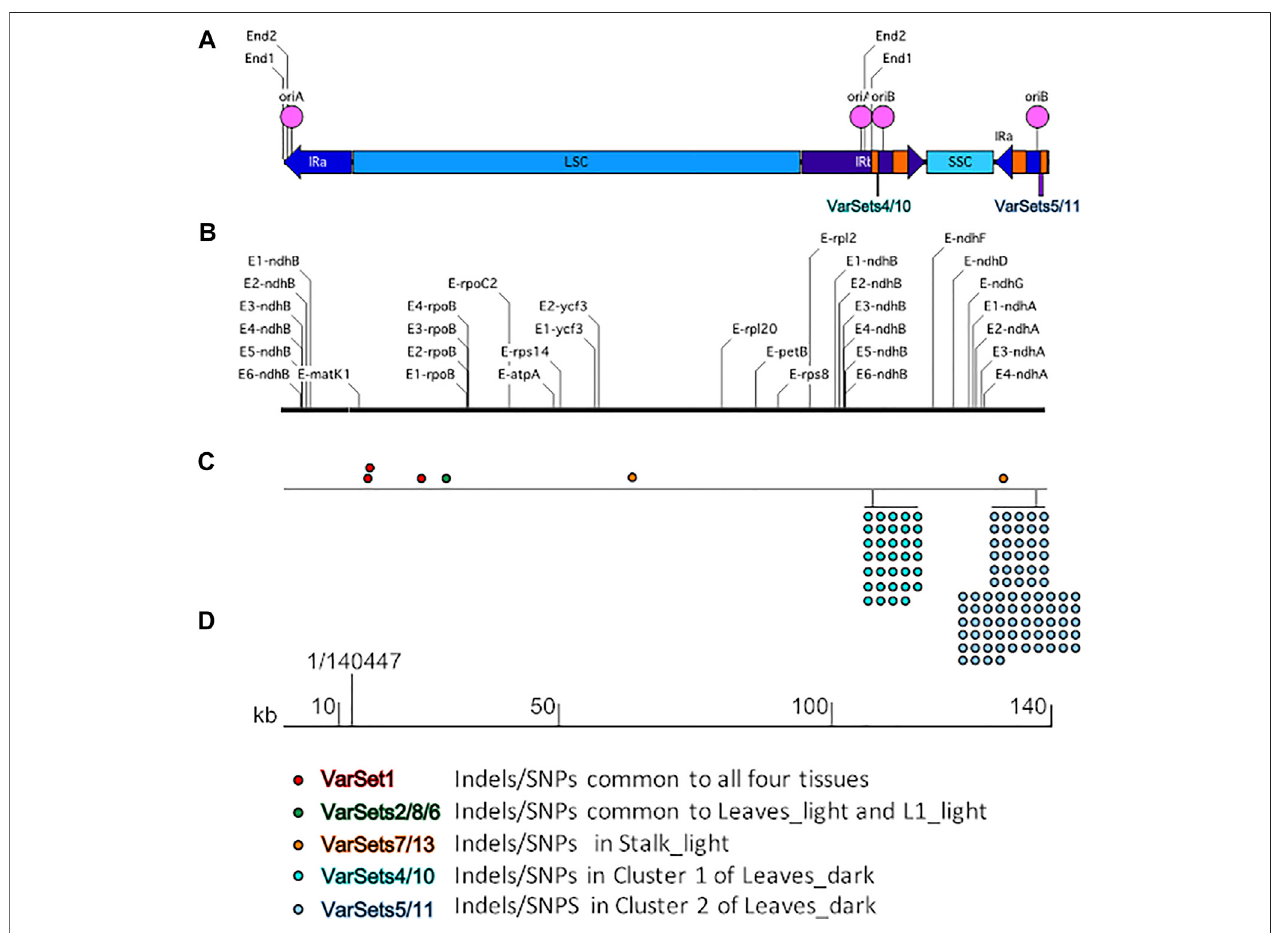
FIGURE 2 | Schematic to show the RNA editing sites and variants in the maize plastid genome. (A) The linear isomer End1-IRa-Iso2 of the plastid genome where the left and right ends are located in the IRa region. The primary regions LSC, SSC, IRb, and IRa are indicated by blue bars and labeled accordingly, the orange bars indicate the location of the 23S (wide bar) and 16S (narrow bar) rRNA genes, the pink circles indicate the location of the origins of replication oriA and oriB, the lines indicate the location of Ends one and two in both IRa and IRb, and locations of the two variant clusters are indicated by purple bars. (B) The RNA editing sites. See SupplementaryFigureS4 forlistofsitesandlocationontheplastidgenome. (C) Variantsetsonthegenome.Colorcodingofthedotsandcorrespondingtissuewhere thevariantswerefoundisshownatthebottom. (D) Scaleinkbandthe1/140,447indicatesthepositionofthereferencegenomebeginning/endnucleotides.Thevariant sets shown here are predicted by Illumina DRAGEN 3.8 variant caller software. Only variants that passed the DRAGEN QUAL fi lter were used in the analysis.